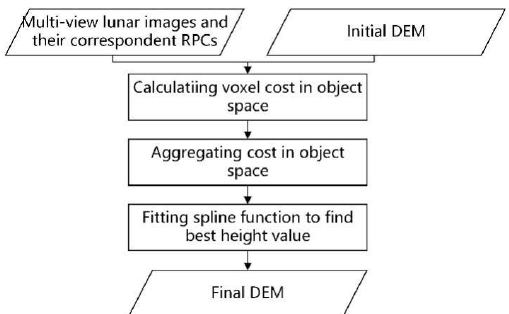
Figure 1. Workflow of the lunar terrain reconstruction from multi-view